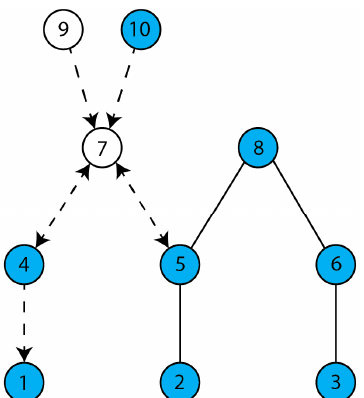
Figure 4. Disassembly network of the frame presented in Figure 3. Building elements are presented as nodes and connections as edges. This graph eases the visual distinction between reversible (left side) and irreversible (right side) connections.